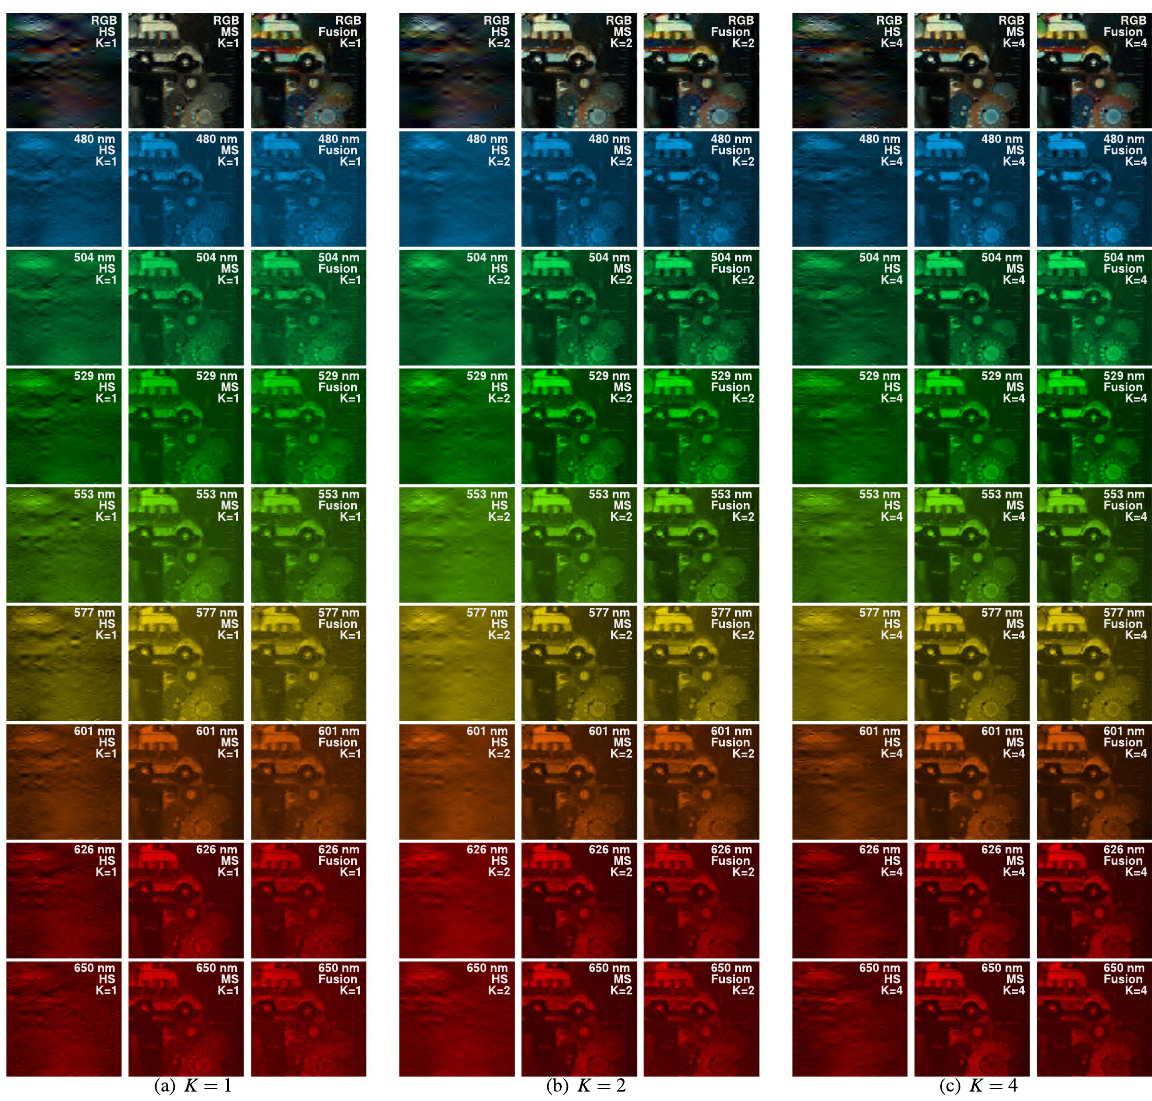
Figure 5. Spectral image reconstructions of the first target scene. From left to right, three columns per snapshot are shown: ( a ) Results for K = 1 , ( b ) Results for K = 2 , and ( c ) Results for K = 4 . From top to bottom, rows show the sRGB-mapped representation of the spectral reconstructions, along with 8 out of the 192 spectral bands. The wavelength, reconstruction method, and the number of snapshots employed are detailed at the top right of each sub-image. This figure was created with Matlab R2019b, https:// www. mathw orks. com/ produ cts/ matlab. html, from data acquired with our imaging reconstructed image quality improves as the number of snapshots increases, independently of the method used. This improvement is appreciated when comparing the HS (columns 1, 4, 7), MS (columns 2, 5, 8), and the fusion (columns 3, 6, 9) reconstructions, separately. Further, although difficult to note, the MS spectra tend to remain constant along contiguous spectral bands, while the HS and fusion reconstructions exhibit noticeable changes between neighboring spectral bands. To better appreciate this behavior, the columns of Fig. 6 depicts four representative spectral signatures of the first target scene, measured with the spectrometer (denoted as ground-truth, black solid line), which are compared against the ones reconstructed with the different methods, MS (blue dashed line), HS (yellow dotted line), and fusion (red dash-dotted line). The rows show the results with different number of snapshots. The RMSE for each scenario is detailed in each subfigure legend within parenthesis. Note first, that the spectral signatures better approach the ground-truth as the number of snapshot increases; second, the signatures resulting from the fusion method attain the best fit to the ground-truth; third, the MS signatures are the smoothest and therefore fail in most of the cases (although their spatial extent looks pleasant in Fig. 5); fourth, the HS and fusion signatures are spikier, thus exhibiting better spectral resolution, but the HS signatures look noisier due to the poor spatial quality of their neighborhood.